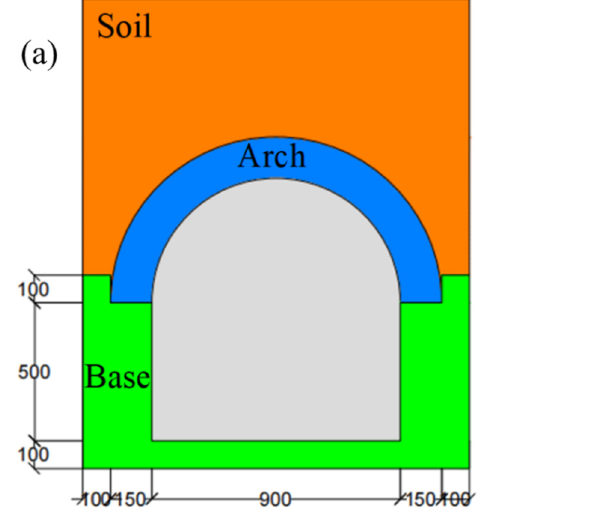
Figure 4. ( a ) Schematic diagram of the shallow buried BBCA (mm), and ( b ) Assembling of the experimental arches and the base [25].